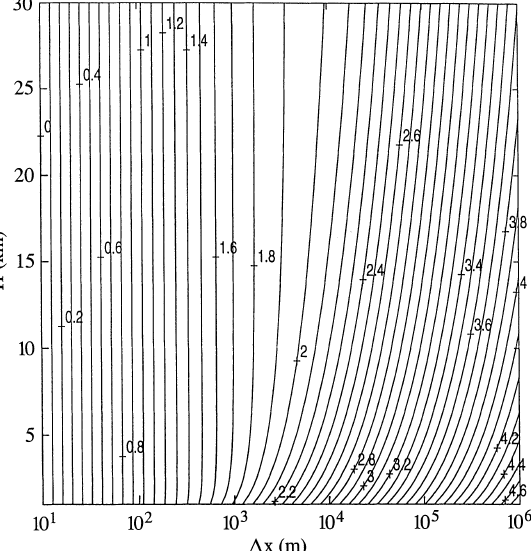
Fig. 7. Values of log (cid:133) (cid:68) t lim (cid:134) , where (cid:68) t lim is in seconds, for U (cid:136) 10ms (cid:255) 1 , N (cid:136) 0 : 01s (cid:255) 1 , and (cid:68) z